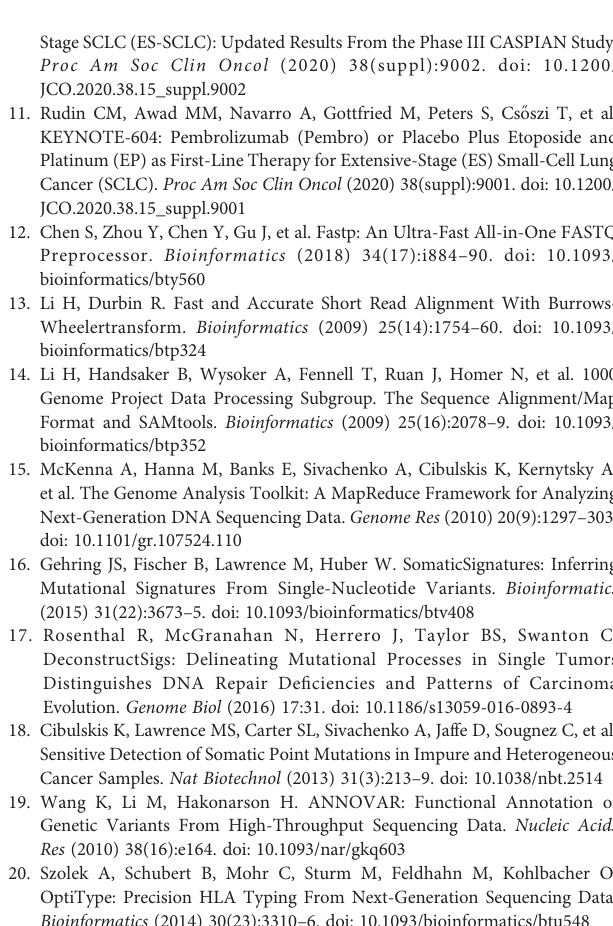
Supplementary Figure 6 | TheVAF analysis of the two group.VAF, variant allele fraction. Supplementary Figure 7 | PFS of CTDP1different mutation status. Supplementary Figure 8 | PFS of KLF5different mutation status. Supplementary Figure 9 | PFS of NFATC1different mutation status. Supplementary Figure 10 | PFS of SYTL1different mutation status. Supplementary Figure 11 | PFS of TTLL10different mutation status. Supplementary Figure 12 | OS of PQLC1different mutation status. Supplementary Figure 13 | Comparison of copy number variations between the twogroupandtheirenrichedbiologicalfunctions. (A) Venngraphsshowingdifferent deletionfocal CNV genes between the two group predicted by the GISTIC method (FDR q < 0.1). (B) KEGG pathways and GO functions enriched by focal CNV genes that signi fi cantly affected PFS time. Supplementary Figure 14 | Comparison of genomic instability between two groups. Supplementary Table 1 | Eigenvalues of the two groups in